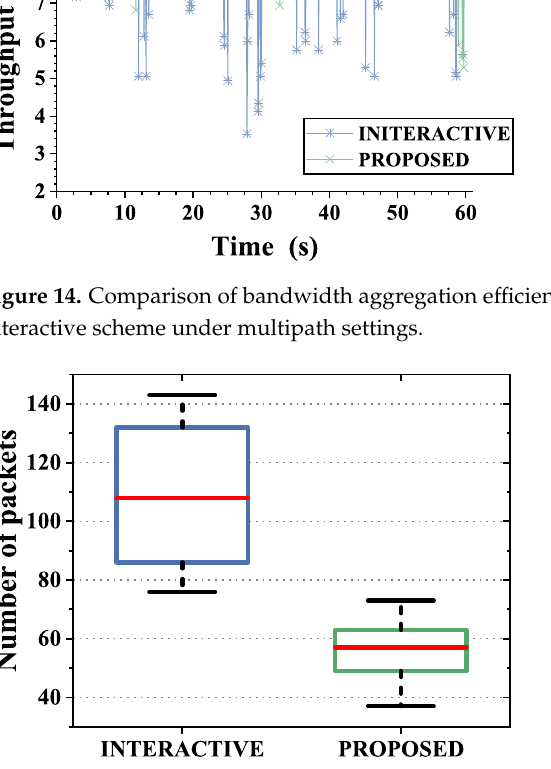
Figure 15. Box plot statistics of out-of-order packets of the proposed scheme and interactive